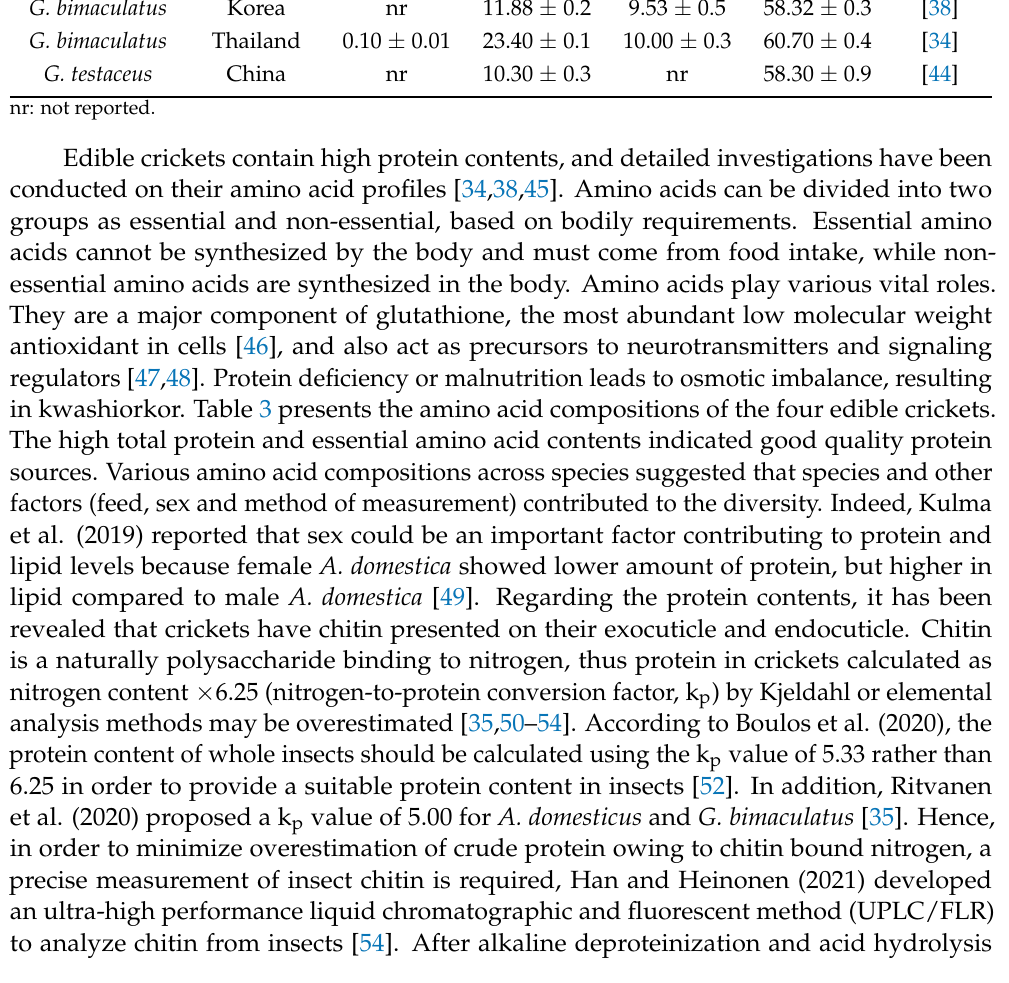
Table 2. Nutritive analysis of four non-processed edible crickets. Nutritive Values (% Dry Matter) Species Sources Carbohydrate Fat Fiber